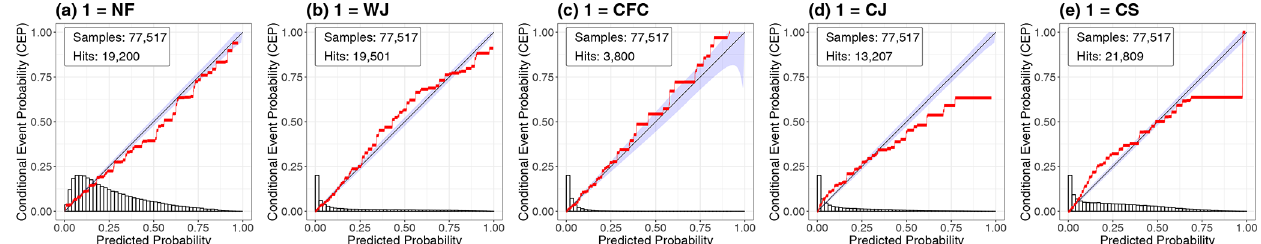
Figure 6. CORP reliability diagrams of the RF probabilities for the individual wind features in the one-against-all approach including all 12 storms.